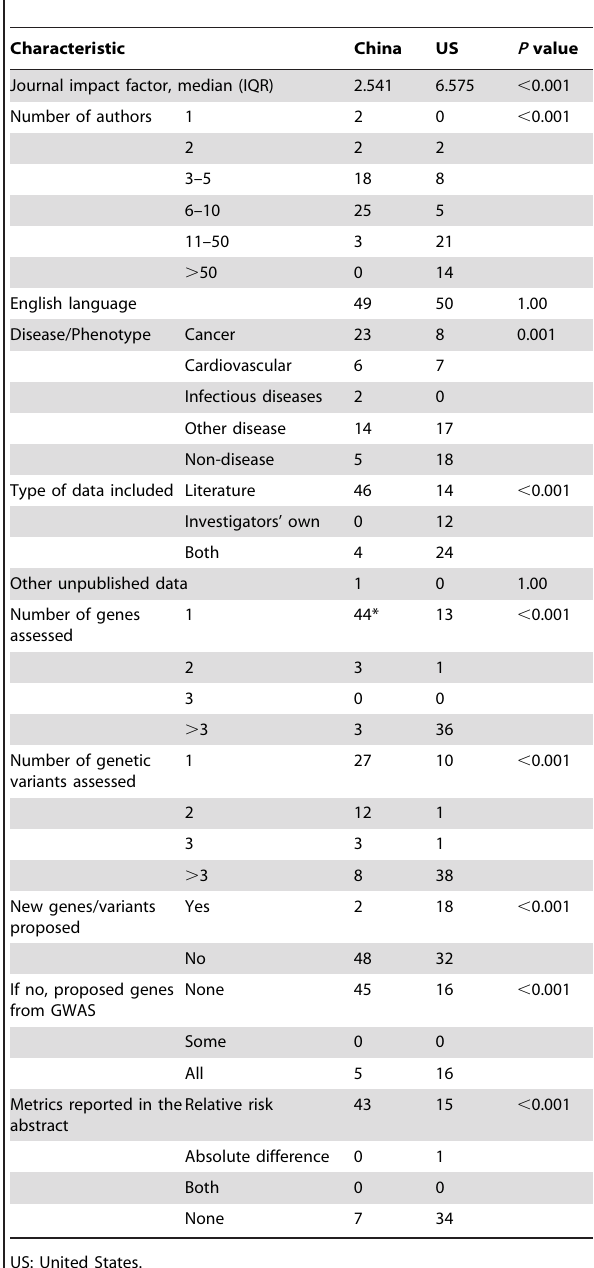
Table 4. Comparison of Characteristics of Genetic Association Meta-analyses Published in 2012 from China and